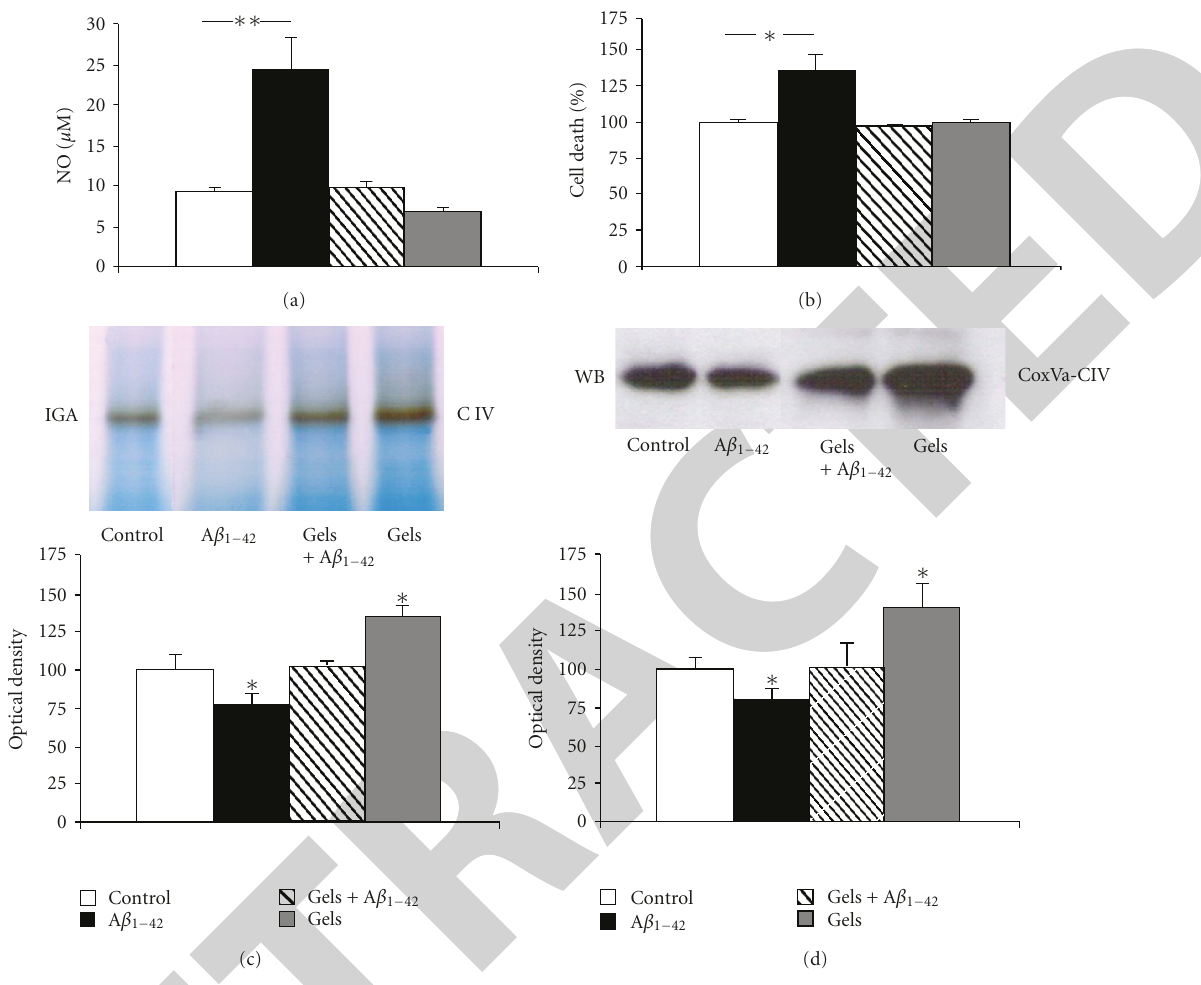
Figure 3: Secreted gelsolin expression modulates NO production and cell death in choroid plexus epithelial cells. (a) Choroid plexus epithelial cells treated with A β 1–42 for 48 hours exhibited a significantly enhanced NO production compared with untreated cells. Secreted gelsolin coadministration completely blocked this e ff ect ( n = 3); ∗∗ P < . 01. (b) Increased cell death was observed in choroid plexus cell cultures 48 hours after A β 1–42 treatment, and gelsolin addition totally reversed this toxic e ff ect ( n = 3); ∗ P < . 05. (c and d) A β 1–42 treatment reduced mitochondrial complex IV in-gel activity in choroid plexus epithelial cells, whereas secreted gelsolin administration increased complex IV activity and reversed this decrease in A β 1–42 -induced activity. Blue native analysis of these culture samples showed altered protein expression in the mitochondrial complex IV. Representative blue native blots and quantitative histograms are shown ( n = 4 per group); ∗ P < .